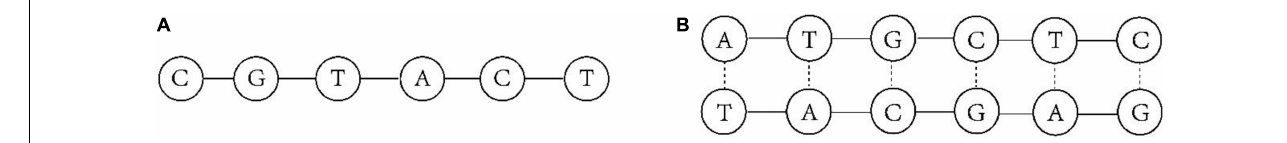
FIGURE 1 | DNA model. (A) single-stranded DNA. (B) double-stranded